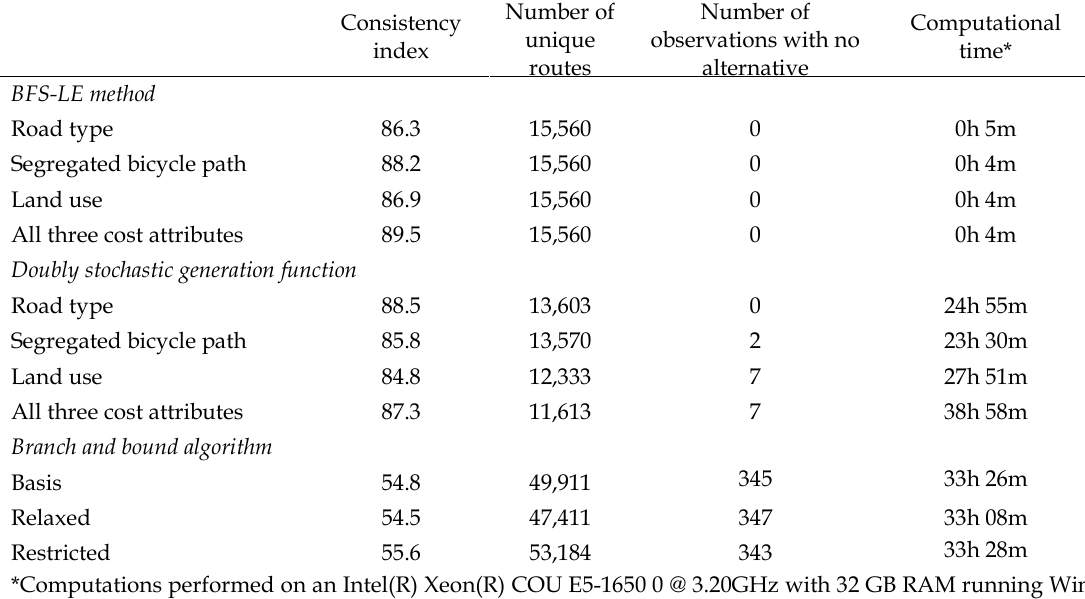
Table 4. Computational costs and techniques consistency